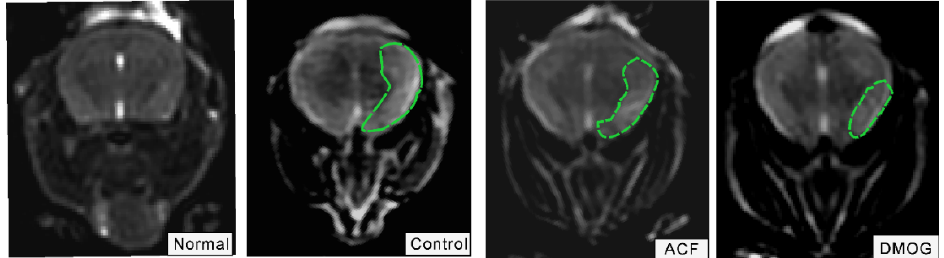
Figure 2. T2W Magnetic resonance image for mice brains following 48 h from ET-1 injection. The high-intensity region represents the infarct area [green dotted line]. DMOG group show smaller infarct volume than Control and ACF groups n = 4.